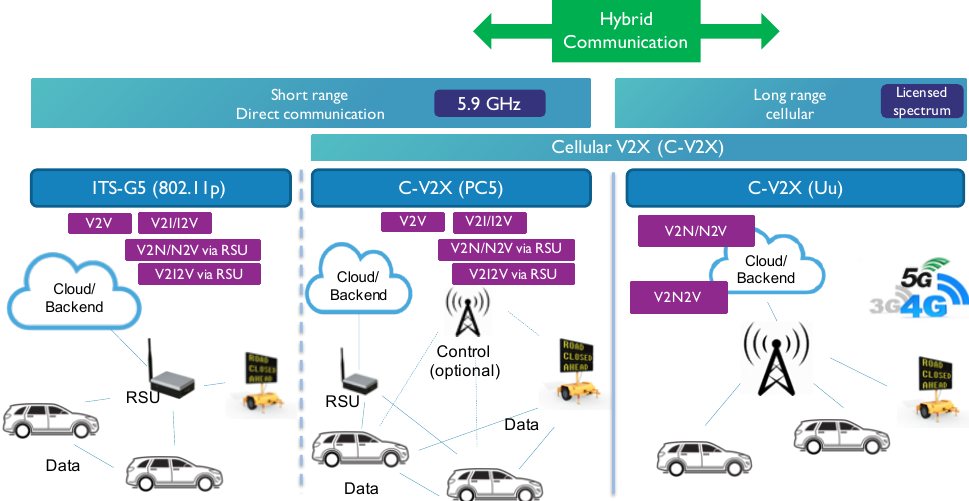
Figure 1. Vehicle-to-Everything (V2X) technology